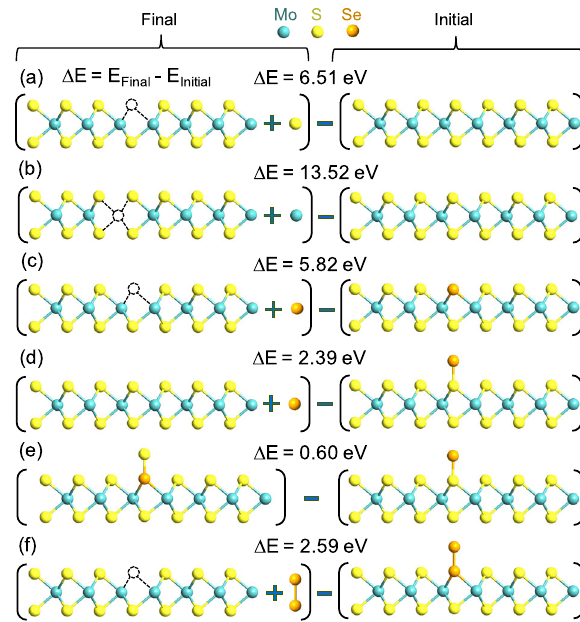
Fig. 1 Energetics of various defect con fi gurations in MoS 2 ML, which can form upon Se ion impacts. The energy required to form a S vacancy ( a ) and Mo vacancy ( b ) is determine by taking the corresponding atom to in fi nity. Filling of a S vacancy by a Se atom ( c ) is energetically preferable over forming an adatom ( d ). Panel e illustrates the energetics of an atom exchange and f an interaction of the S vacancy with Se